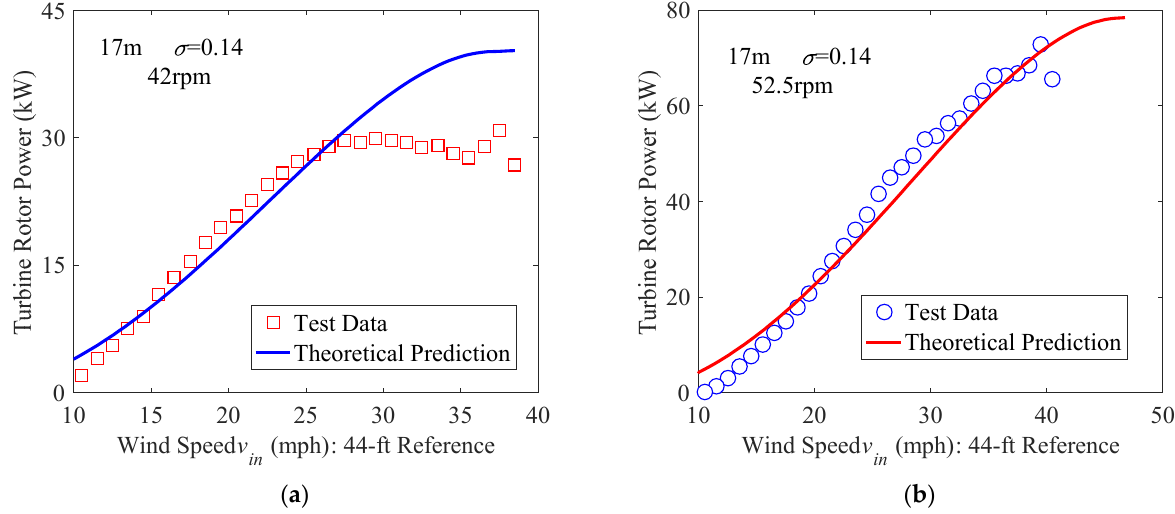
Figure 9. Performance of the Sandia turbine [2]: comparison of results at ( a ) Ω = 42 rpm and ( b ) Ω = 52.5 rpm.